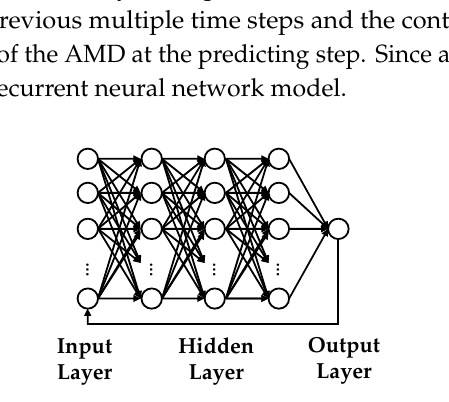
Figure 5. Illustration of an autoregressive with exogenous inputs model.